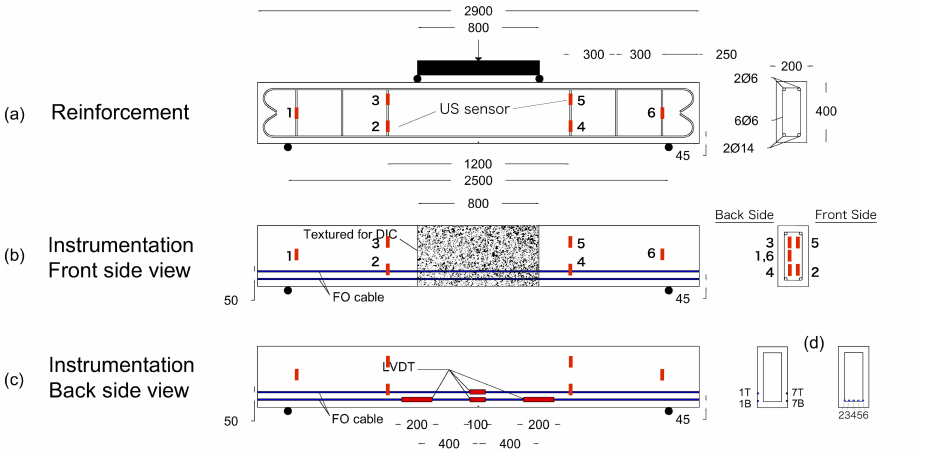
Figure 6. Dimensions of the beam, rebars distribution and sensors positions at BAM.